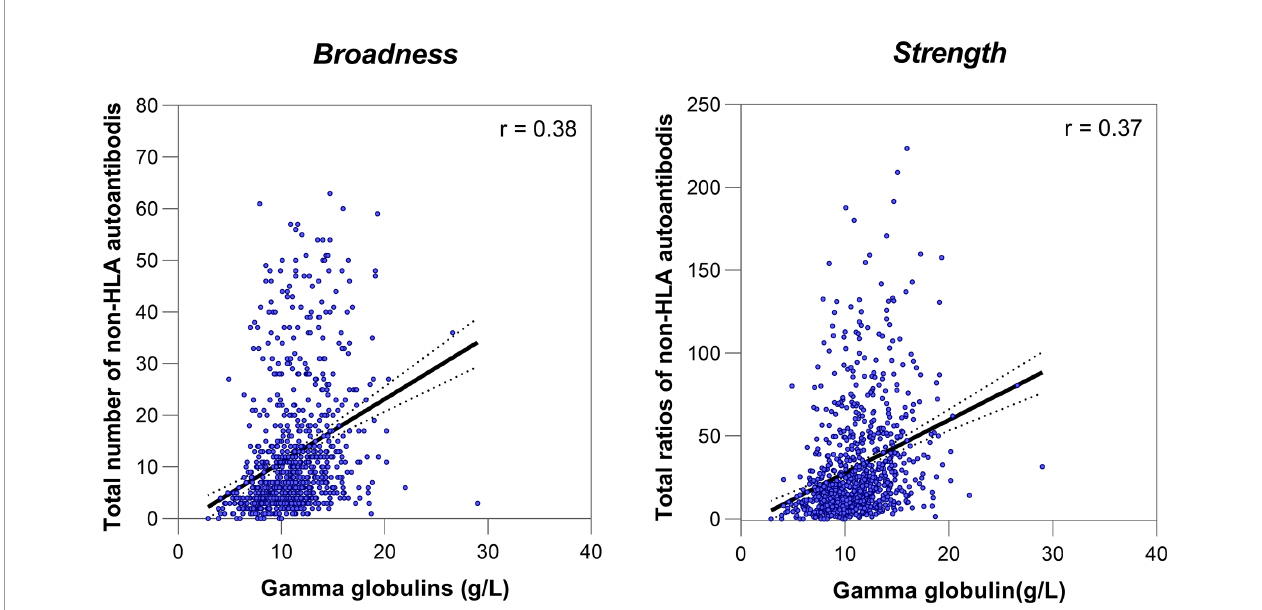
FIGURE 4 | Correlations between the pretransplant non-HLA antibodies and total serum gamma globulins.